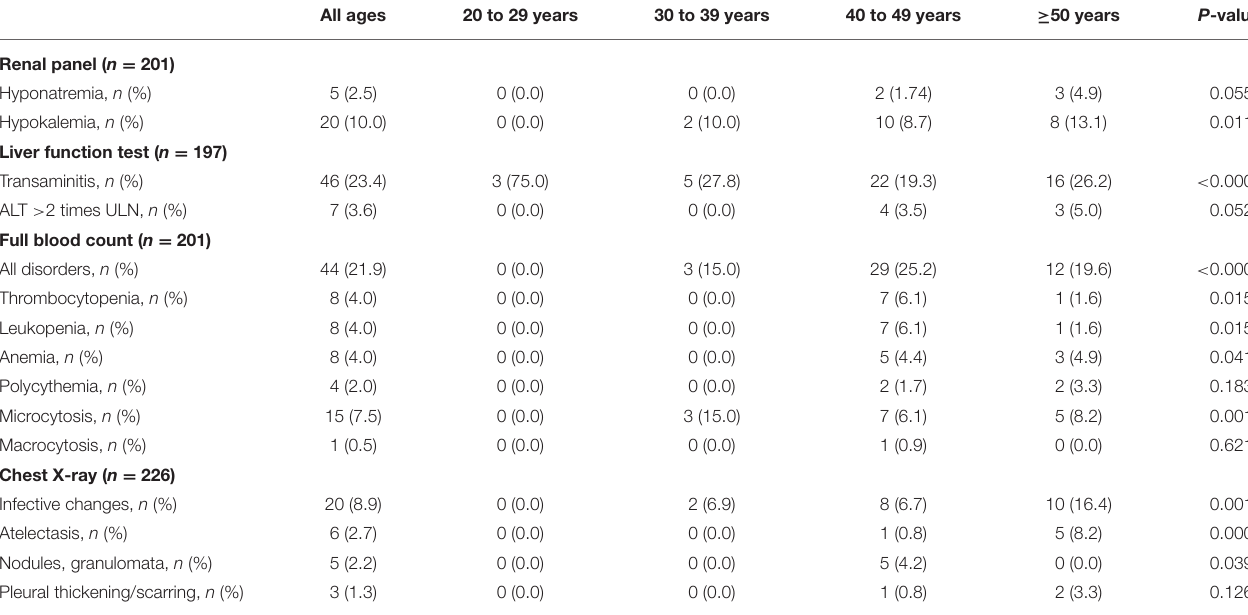
TABLE 3 | Incidence of laboratory and radiographical abnormalities, stratified by age. All ages 20 to 29 years 30 to 39 years 40 to 49 years ≥ 50 years P -value